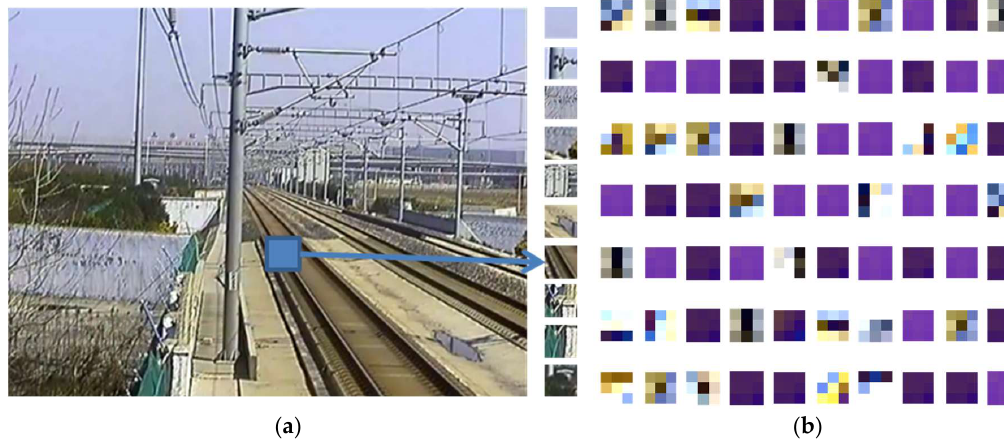
Figure 11. Pre-trained convolution kernels using the autoencoder-decoder algorithm. ( a ) The image patches are extracted from the left railway scene image for the kernel training. ( b ) The pre-trained kernels used in convolution layer C1 .